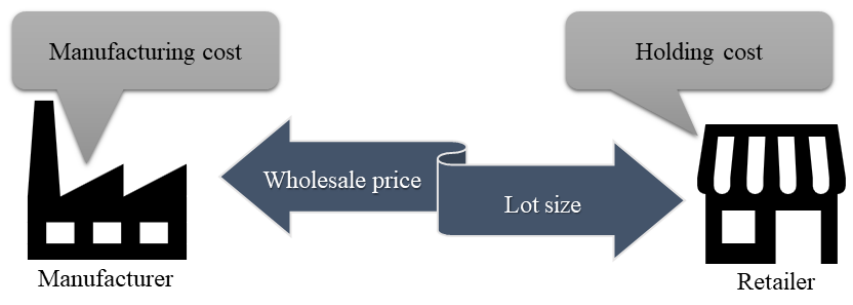
Figure 1. Traditional